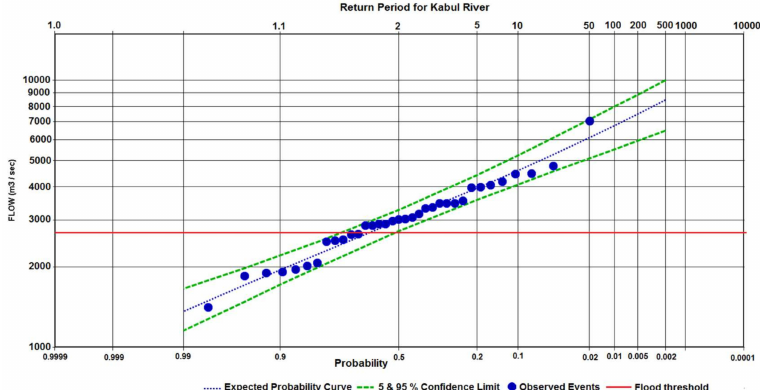
Figure 5. Trends of flooding events in Kabul river. The blue dots are the observed flow recorded over the period of 1981–2015. The higher outlier during this analysis, which was actually the 2010 flood in this region. Y -axis represents the discharge of Kabul River in m 3 s − 1 while the primary X -axis shows the probability while the secondary X -axis shows the return period of the flooding in years. The red line shows the medium level flood (2800 m 3 s − 1 ) as described by the Federal Flood Commission of